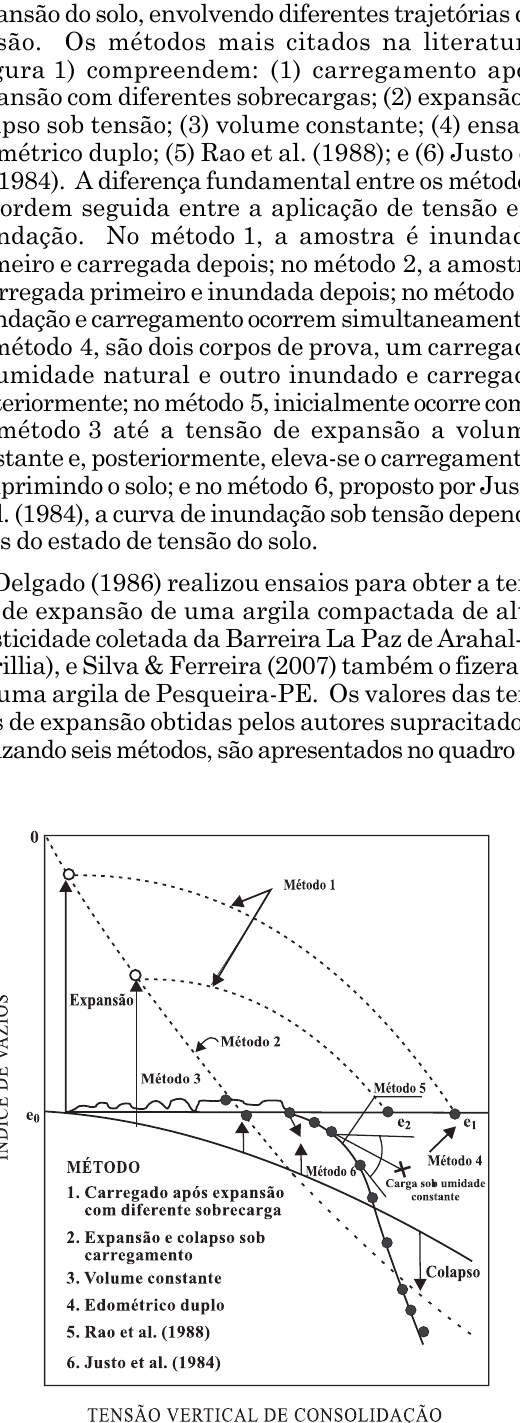
Figura 1. Métodos para determinação da tensão de